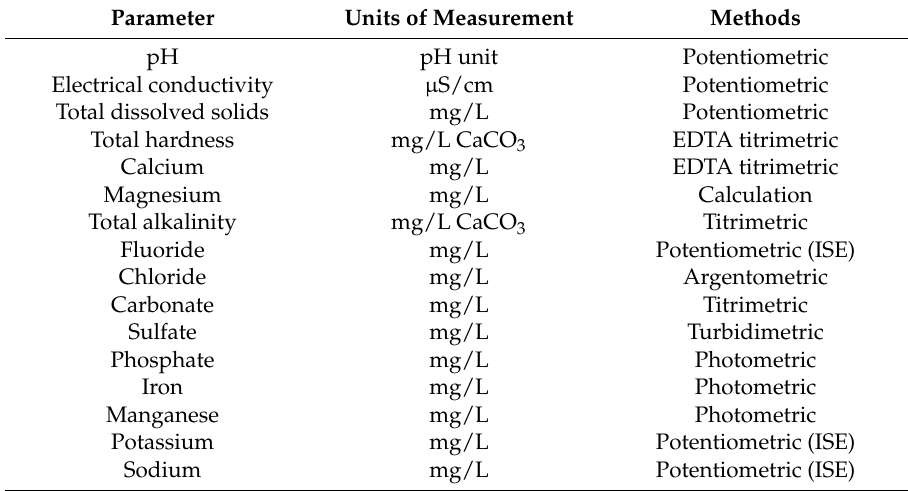
Table 1. List of affordable water analytical methods used at NDRS (modified from Nkongo 2018—personal